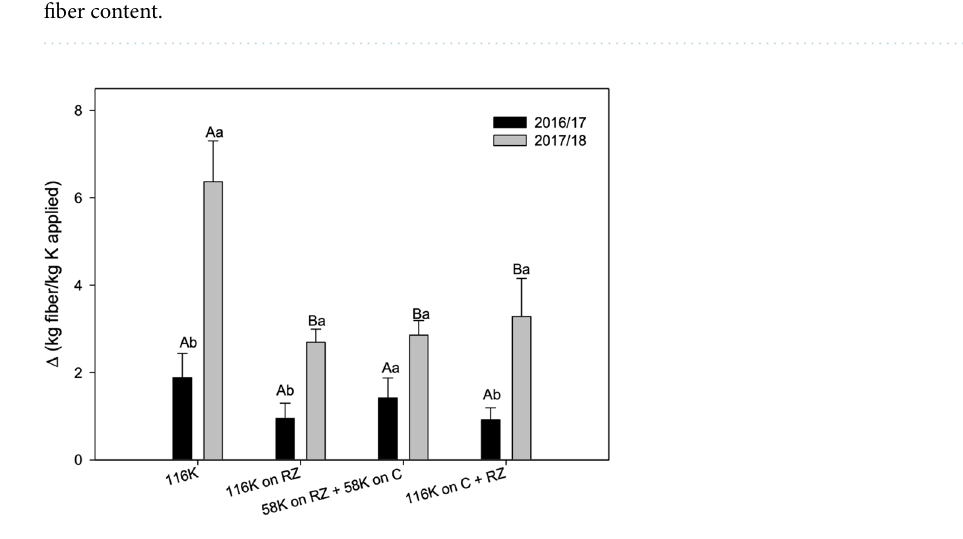
Figure 4. Potassium fertilizer apparent use efficiency (from fertilizer) represented by fiber production per kg of K applied. This index was obtained considering the difference of yield from treatments with no K (0 K for 116 K and 0 K + RZ for the others) divided by 116. A > B for K management within each growing season and a > b for growing season within K